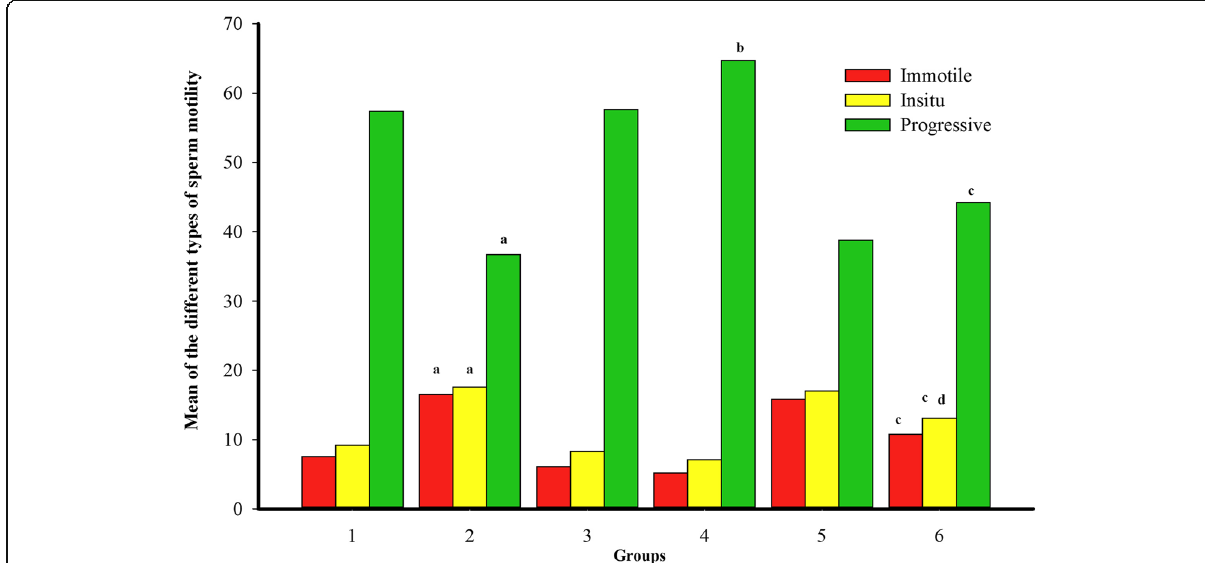
Fig. 2 Comparison of various types of sperm motility grades in study groups. Data show the mean ± SD ( n = 10). a P < 0.001 and b P < 0.05 as compared to normal control group, respectively, c P < 0.05 as compared to nicotine-treated group (Group 2) and d P < 0.05 as compared to 5 group